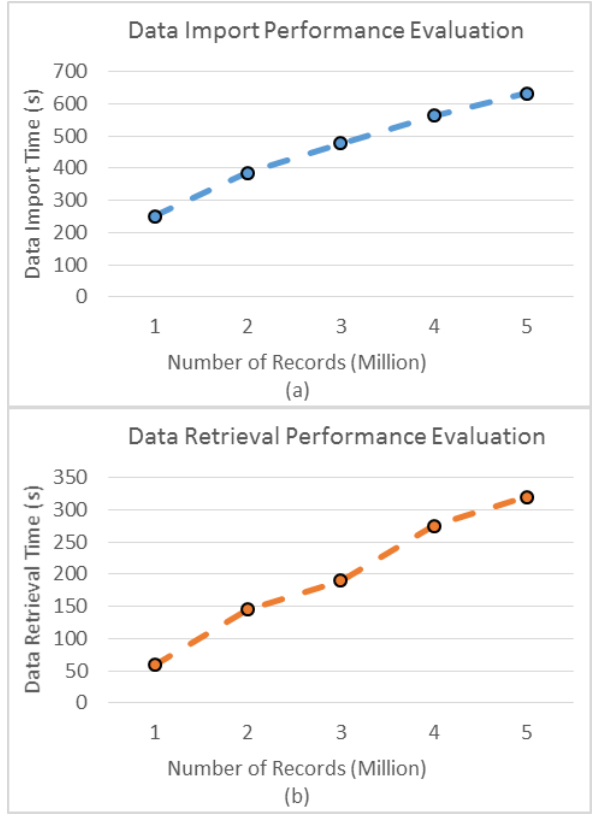
Figure 6. Data management layer evaluation